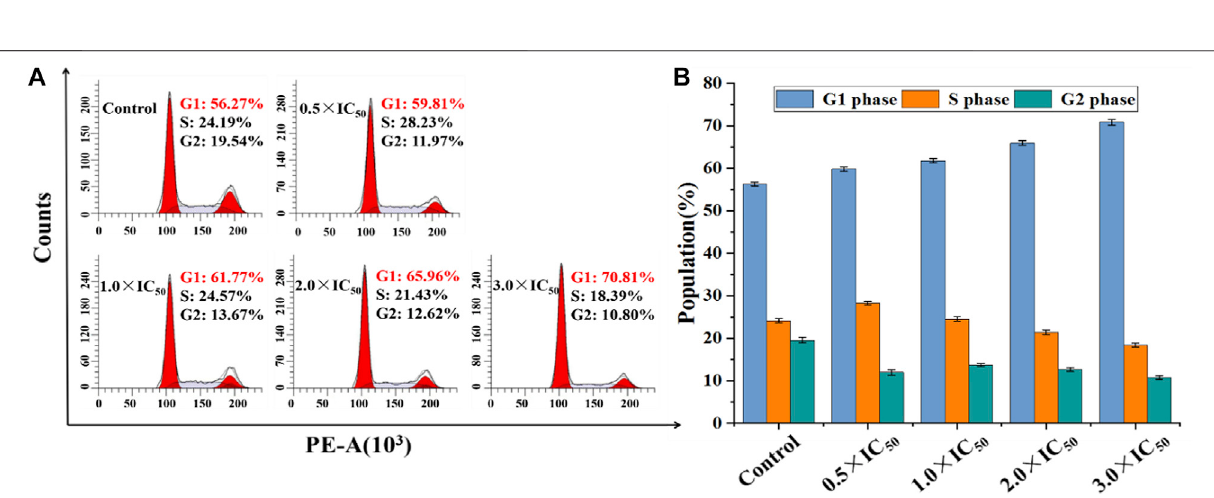
Frontiers in Chemistry |